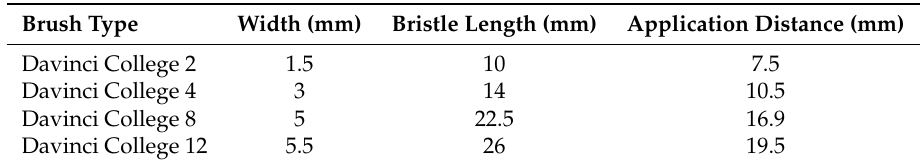
Table A1. Types of